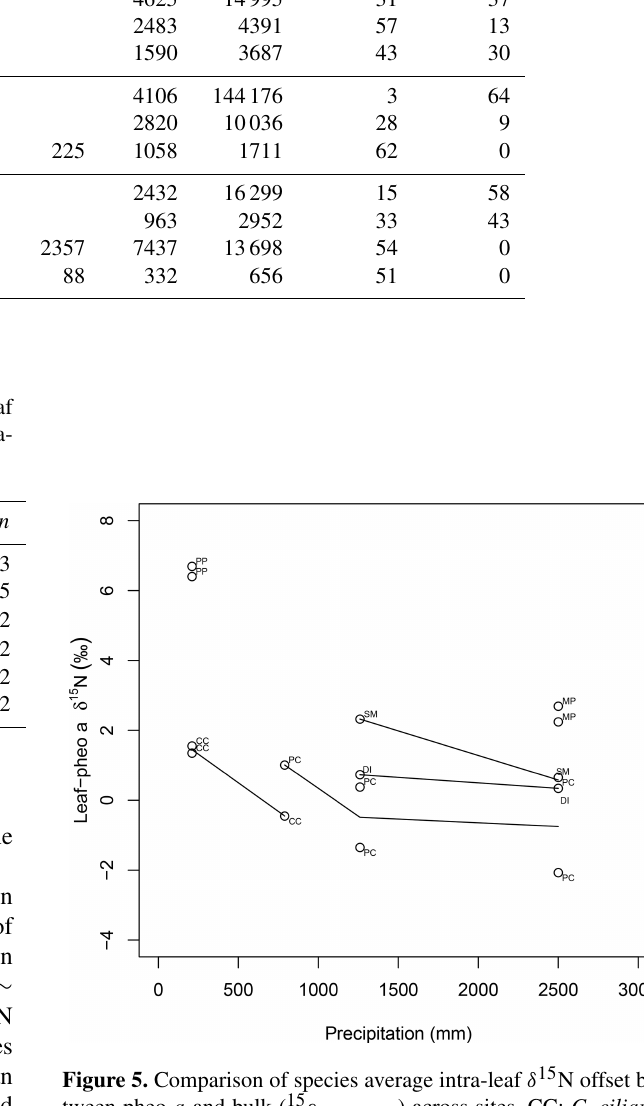
Figure 5. Comparison of species average intra-leaf δ 15 N offset be- tween pheo a and bulk ( 15 ε pheo − leaf ) across sites. CC: C.